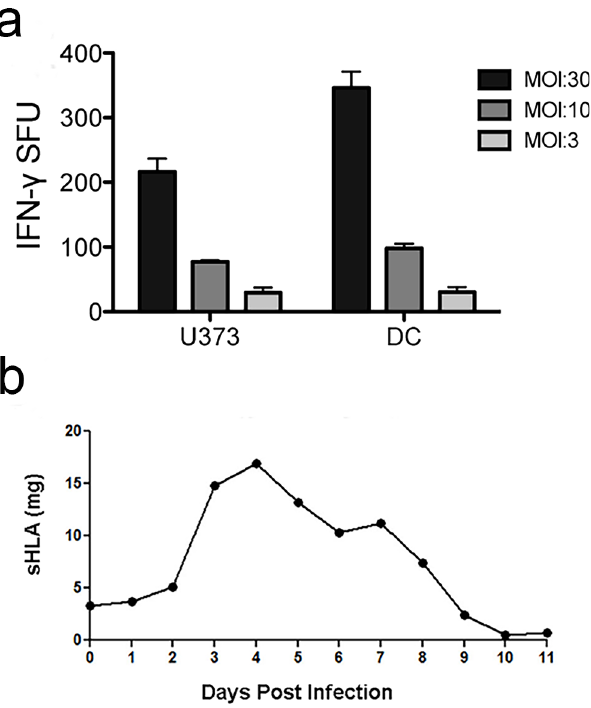
Fig 1. Production of soluble HLA-E from Mtb-infected cells. A) U373 or DC were infected with the H37Rv strain of Mtb (multiplicity of infection (MOI):30, 10, or 3) for 18 hours, then used as antigenpresenting cells in an ELISPOT assay with IFN- γ production by D160 1–23, an HLA-E restricted CD8 + T cell clone, as the readout.B) U373 cells expressingsHLA-E, and grown to high density in a hollow-fiber bioreactor, were infected with Mtb. sHLA-E was measuredin the cell supernatant using